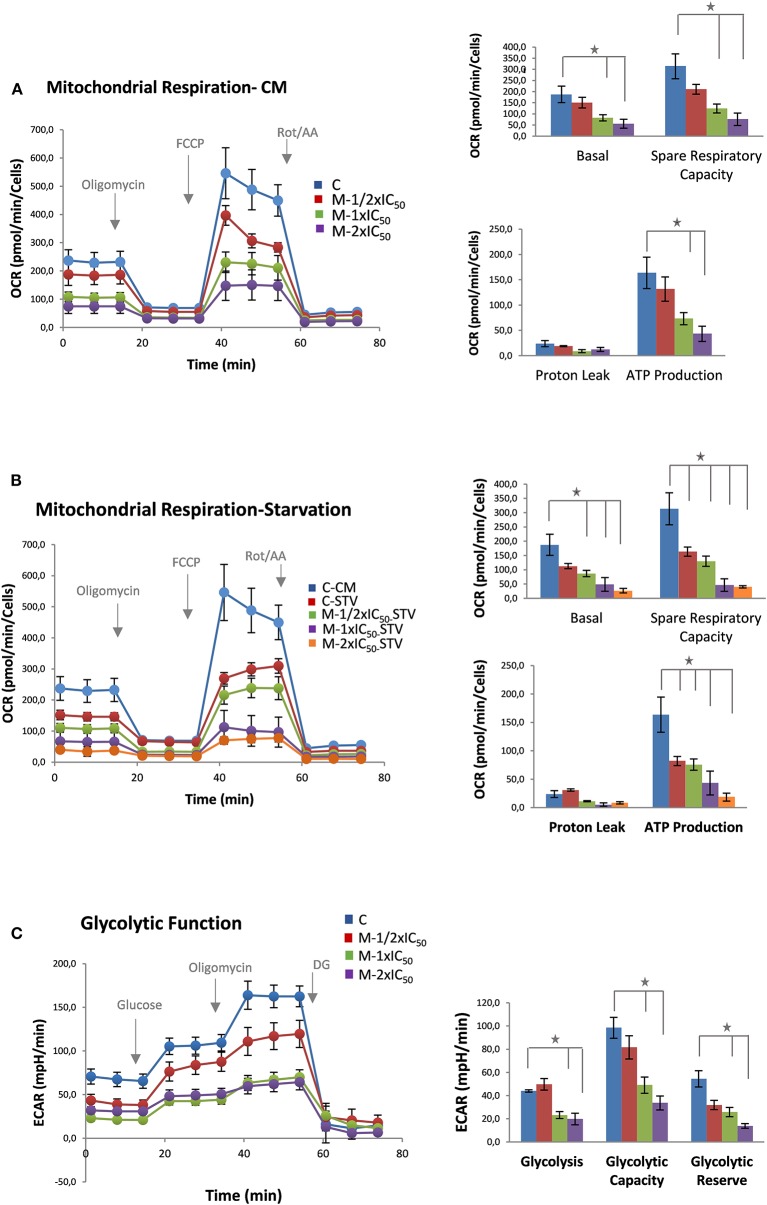
Marigold supercritical fluid extraction (SFE) diminishes cell bioenergetics. (A) Mitochondrial respiration analysis by flux analysis of the oxygen consumption rate (OCR) of MiaPaca-2 cells vs. marigold SFE pretreated cells (½ × IC50, 1 × IC50, 2 × IC50) in complete media (10 mM glucose, 2 mM glutamine, 1 mM pyruvate). Basal respiration rate, spare respiratory capacity, ATP production, and proton leak are shown. (B) Mitochondrial respiration analysis by flux analysis of the OCR in MiaPaca-2 non-treated cells vs. marigold SFE pretreated cells for 48 h prior to the experiment, when kept in low glucose (2.5 mM glucose, 2 mM glutamine, 1 mM pyruvate). A control of non-treated cells in complete media is shown for comparison with control non-treated cells in conditions of low glucose. (C) Glycolytic activity of MiaPaca-2 pancreatic cancer cells. Comparison of the glycolytic function of MiaPaca-2 cells vs. marigold SFE pretreated cells (½ × IC50, 1 × IC50, 2 × IC50) for 48 h prior to the experiment, in conditions of absence of glucose for 1 h (2 mM glutamine). Glycolysis [difference from extracellular acidification rate (ECAR) value in the presence of glucose and ECAR value in starved cells], glycolytic reserve (difference between ECAR after ATPase inhibition and ECAR after glucose injection), and glycolytic capacity (sum of glycolysis and glycolytic reserve) are shown. Representative assays of three experiments. Each experiment contains six replicates per treatment. *P < 0.05.